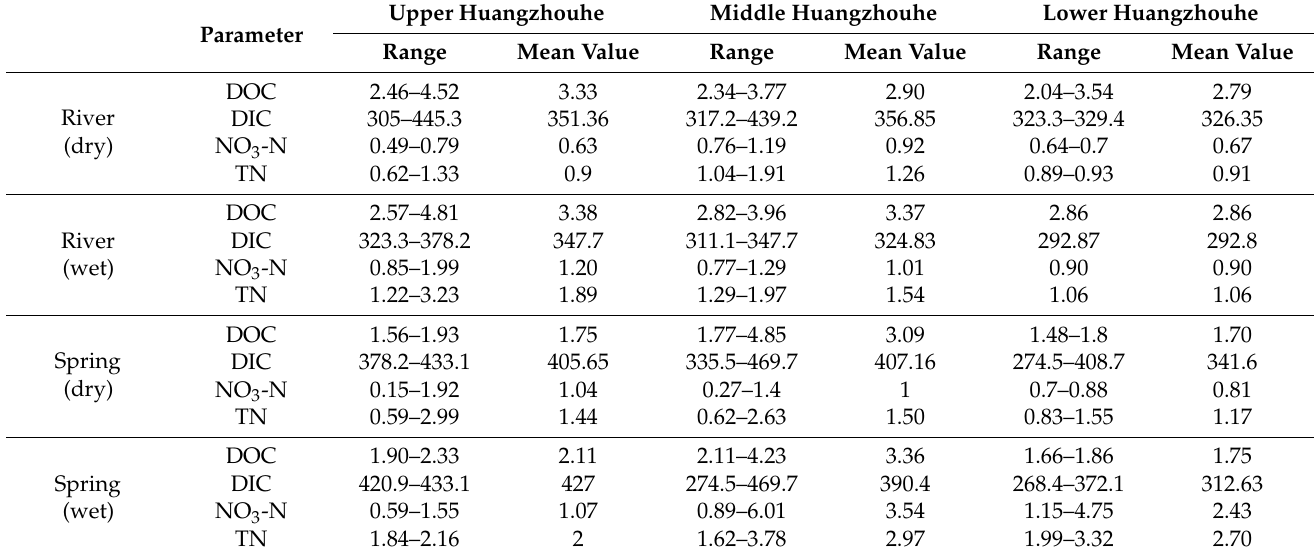
Table 2. C and N species in the Huangzhouhe River Basin (mg · L − 1